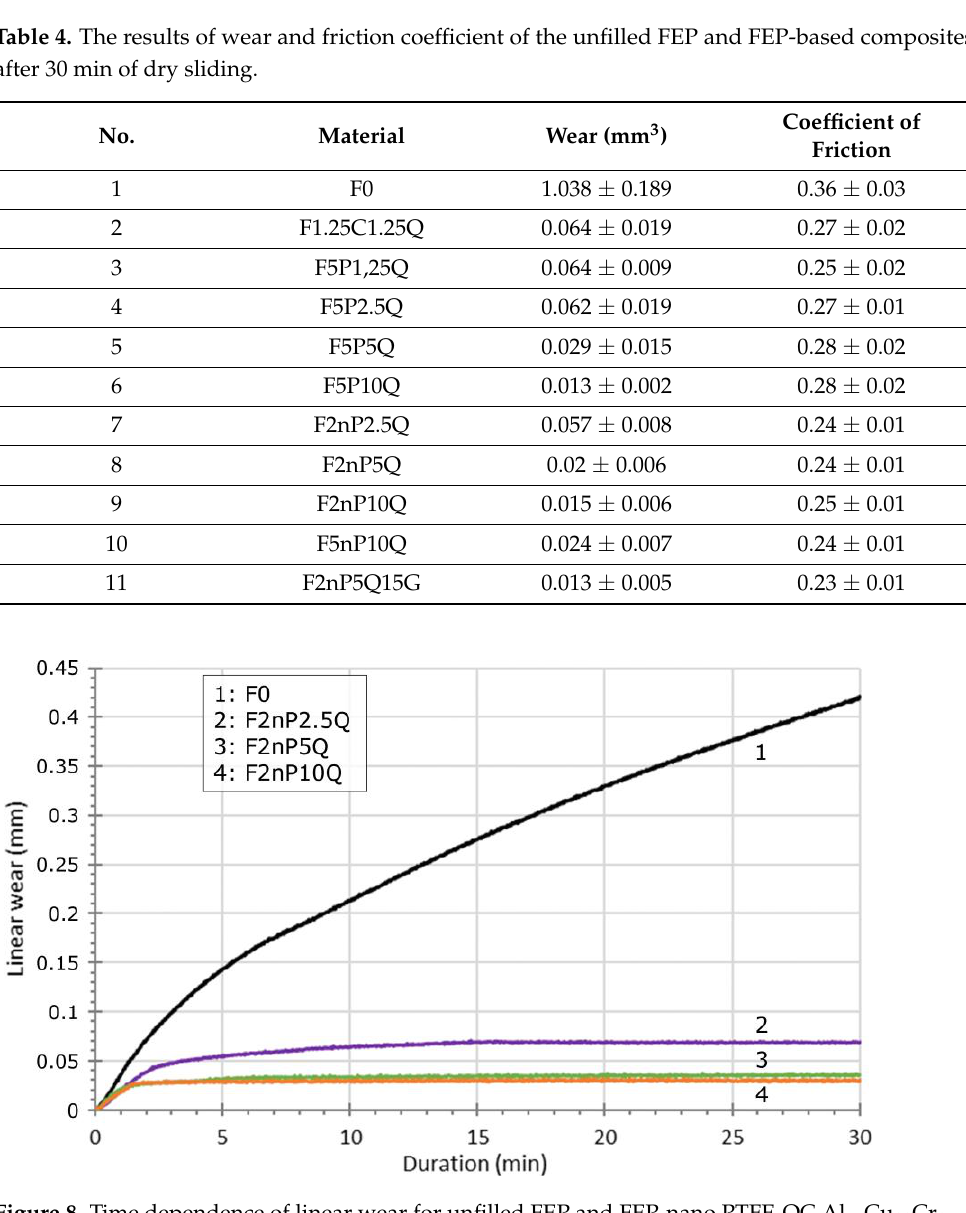
Figure 9. Optical images of steel counterbody surfaces after 30 min of dry sliding contact with. unfilled FEP ( a ) and FEP/1.25 wt.% CB/1.25 wt.% QC Al 73 Cu 11 Cr 16 ( b ). Figure 10 shows the variation of friction coefficient with time for unfilled FEP and FEP-based composites, and the influence of solid lubricants (PTFE, graphite) on the fric- tion coefficient magnitude. With pure FEP, the friction coefficient increases rapidly in the initial stage of sliding, then it reaches a plateau (0.36) after 5 min of sliding, which corre- sponds to the transformation in wear from a high rate to a low rate. Also, it can be recog- nized an elevated level of friction noise on the graph. Latter can be attributed to a poor sliding performance of unfilled FEP. For FEP/PTFE/QC Al 73 Cu 11 Cr 16 or FEP/PTFE-